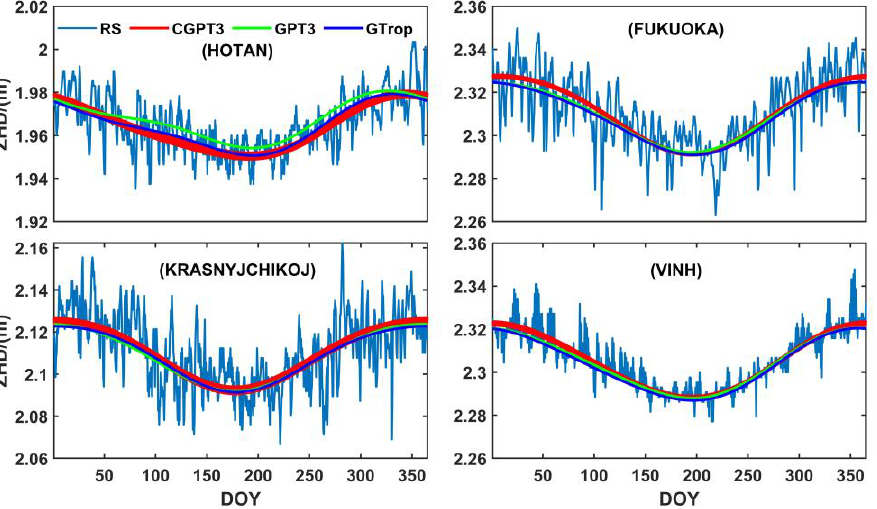
Figure 8. ZHD sequence of the three models and RS at HOTAN, FUKUOKA, KRASNYJCHIKOJ, and VINH sites in 2017.